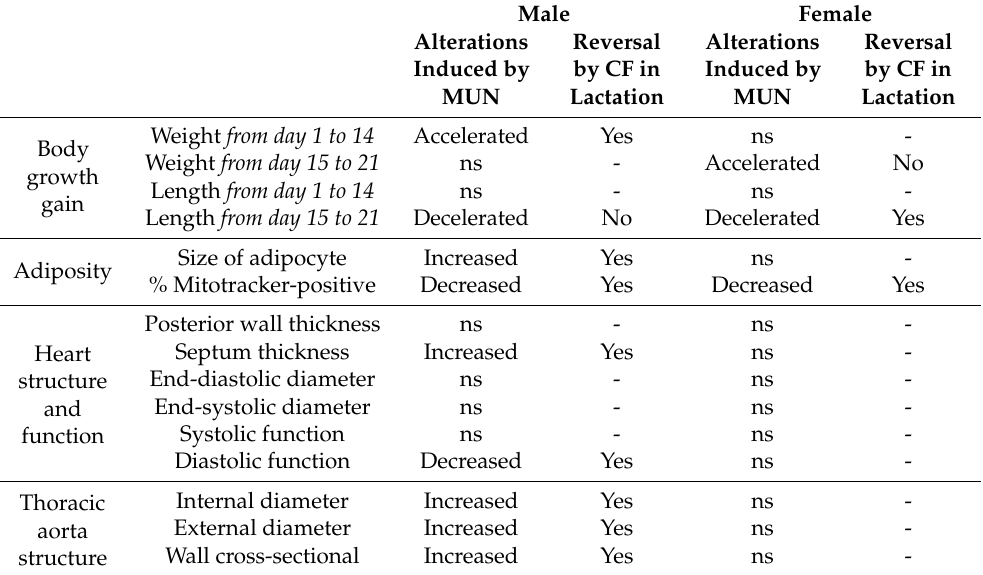
Table 2. Summary of main